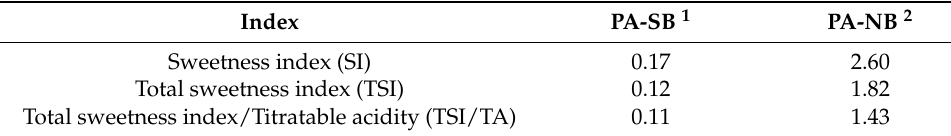
Table 3. Sweetness indices of two phenotypes of Physalis alkekengi fruit.